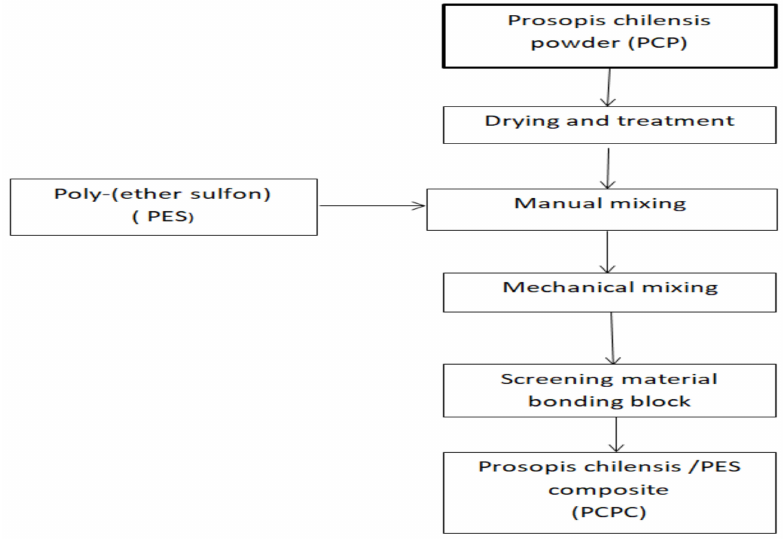
Figure 2. Flow chart of the preparation process of Prosopis chilensis / PES composites (PCPC).